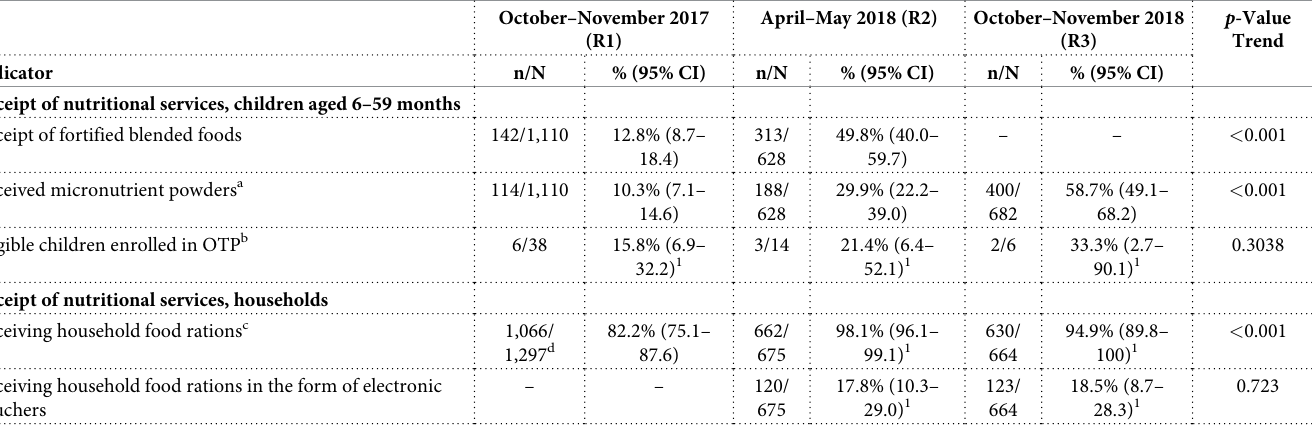
Table 5. Receipt of nutritional services among children 6–59 months of age and households in makeshift and informal settlements—Bangladesh,